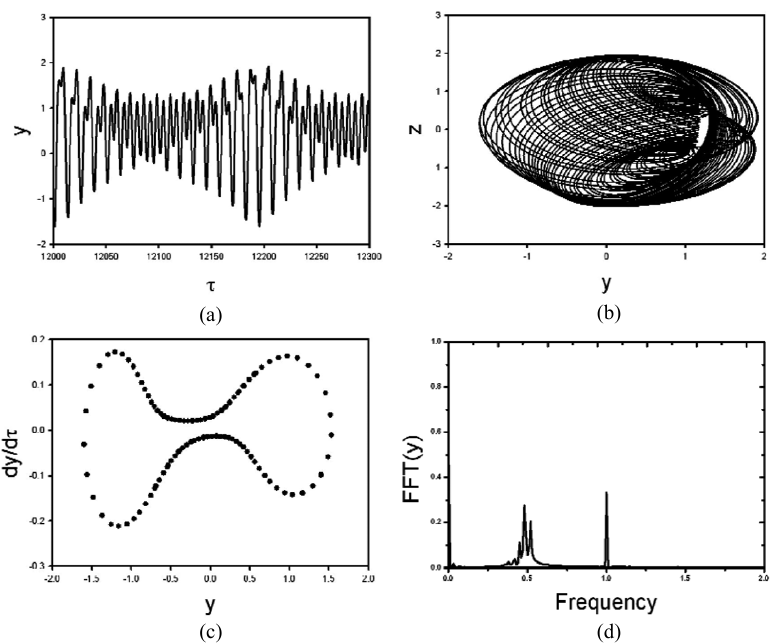
Fig. 18. Dynamic characteristic of the y-displacement of the mid-span point with γ m = 4500 T 2 m/H. (a) Time history; (b) Orbital trajectory; (c) Poincar´e section; (d)